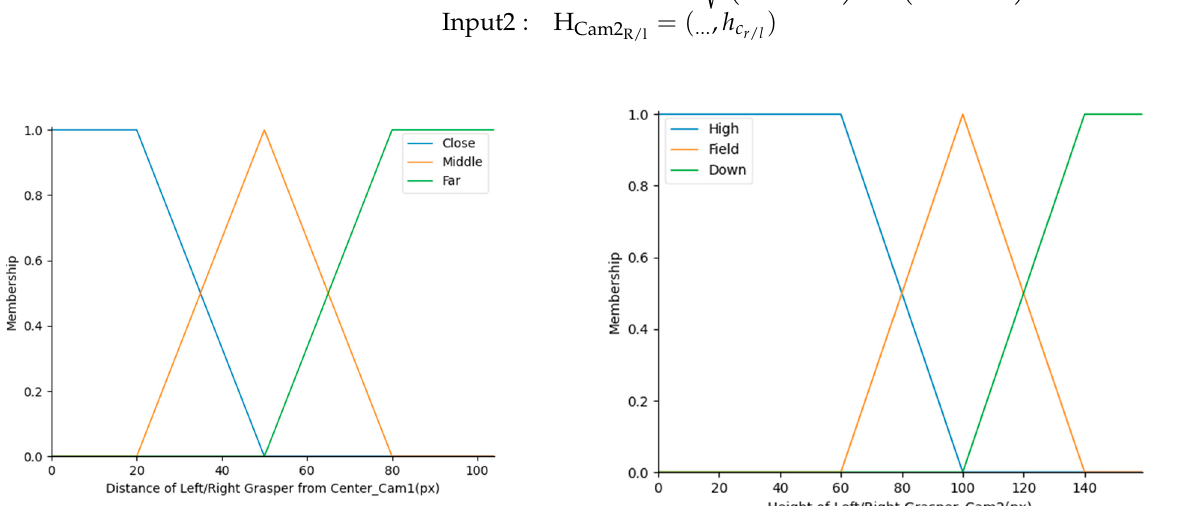
Figure 6. MFs of the input variable for the first level fuzzy logic evaluation system for both the right and left graspers. Table 3. Rule list—First-level fuzzy logic evaluation.